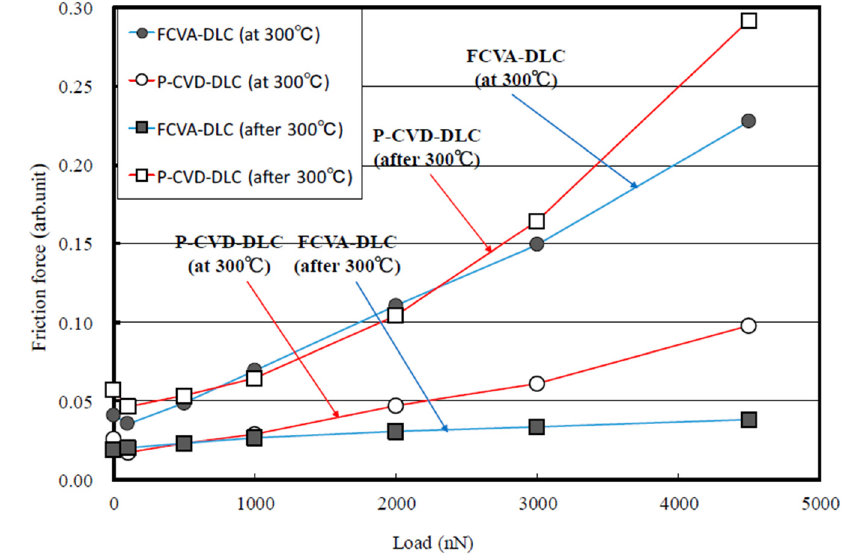
Figure 16. Nano - friction force dependence on load. (300 °C). Figure 16. Nano-friction force dependence on load. (300 ◦